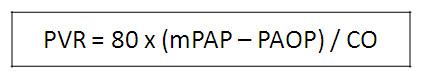
Calculation of pulmonary vascular resistance. Normal range, 155-255 dynes/sec/cm5. CO, cardiac output; mPAP, mean pulmonary artery pressure; PAOP, pulmonary arterial occlusion pressure.